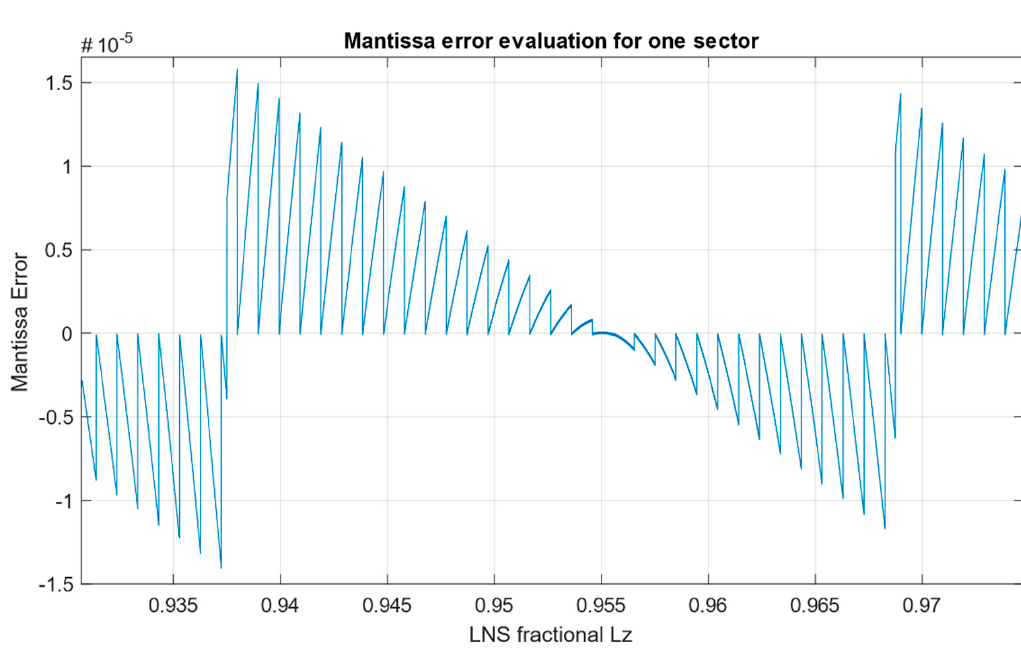
Figure 7. Zoomed mantissa error evaluation for one sector.